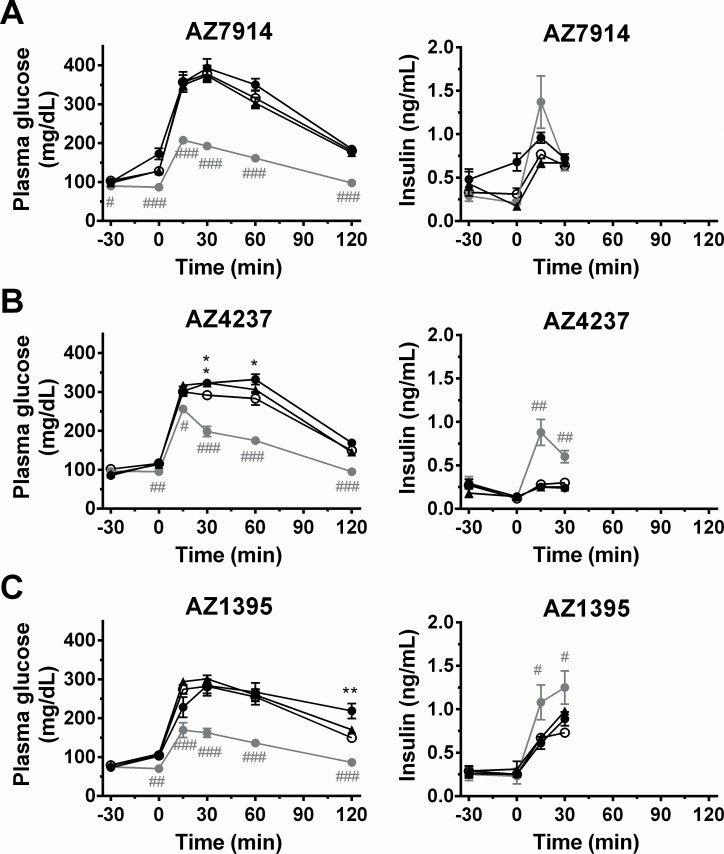
IPGTT in C57BL/6J mice; AZ7914 (A), AZ4237 (B), AZ1395 (C).Compounds (black triangles: 30 mg/kg, black circles: 100 mg/kg, grey circles: exendin-4, 1 μg/kg) or vehicle (white circles) were IP administered to fasted C57BL/6J mice at -30 min. Glucose solution (1.5 g/kg) was given IP at 0 min. Values are mean ± SEM (n = 7). #
P<0.05, ##
P<0.01, ###
P<0.001 versus vehicle (repeated measures ANOVA followed by student’s t-test).*P<0.05, **P<0.01, ***P<0.001 versus vehicle (repeated measures ANOVA followed by Dunnett).